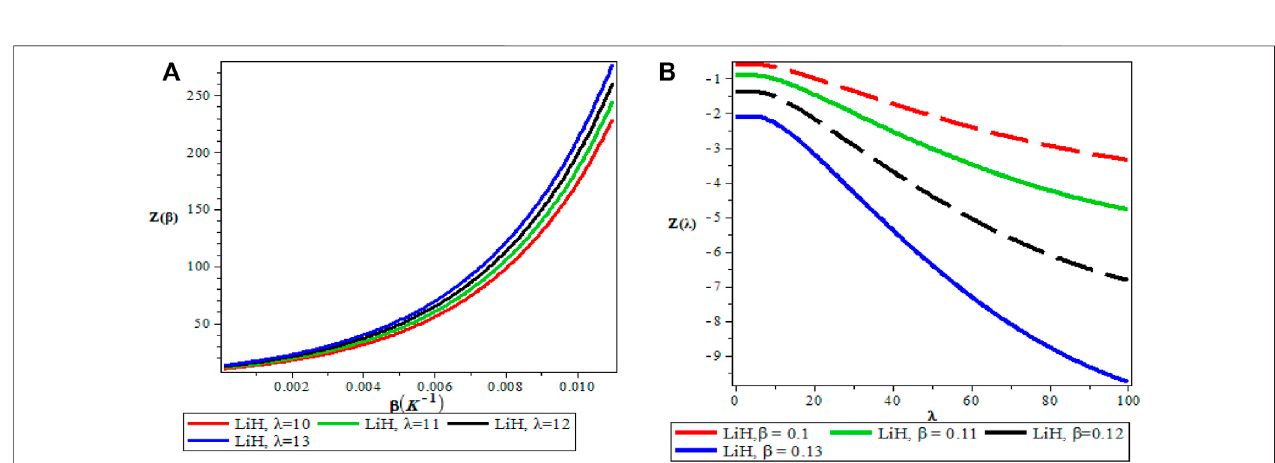
FIGURE 5 | (A) Variation of Partition Function With Respect to β (B) Variation of Partition Function With Respect to λ .